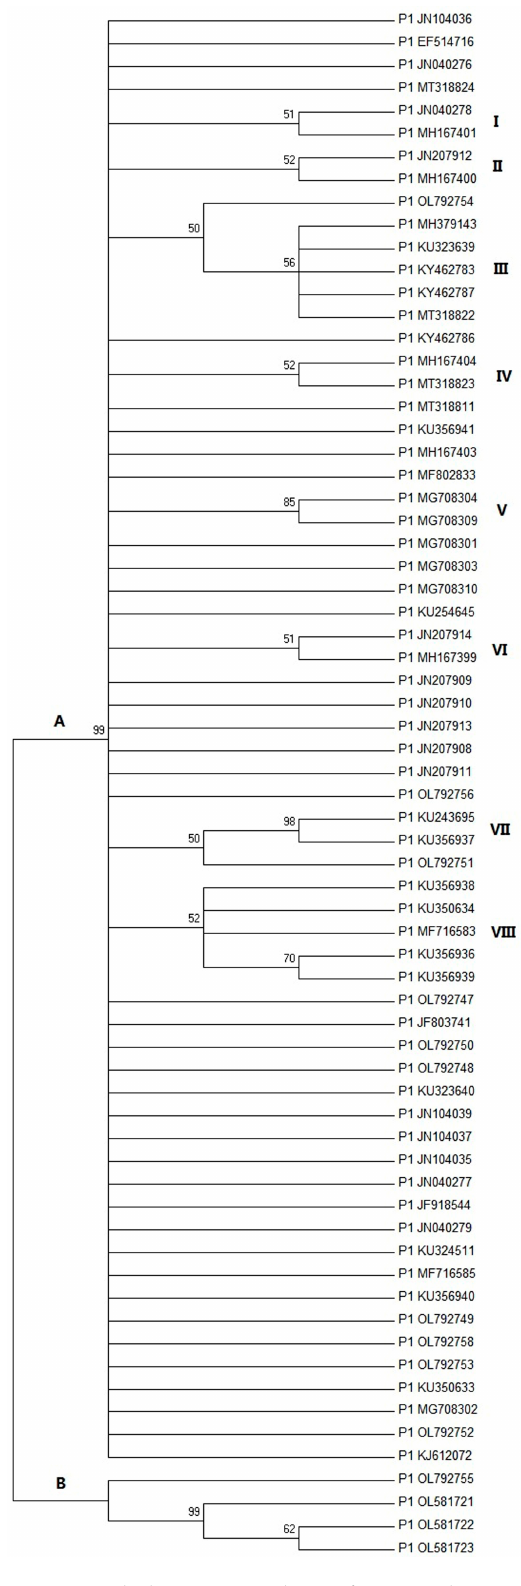
Figure 1. Phylogenetic analysis of 57 complete P1 genomes detected in this study, together with 310 complete P1 genomes deposited in GenBank. The tree was constructed using the neighbor-joining method. The bootstrap consensus tree was calculated from 1000 replicates. Branch support values lower than 50% were not included. P1 strains are represented by their accession number at GenBank.